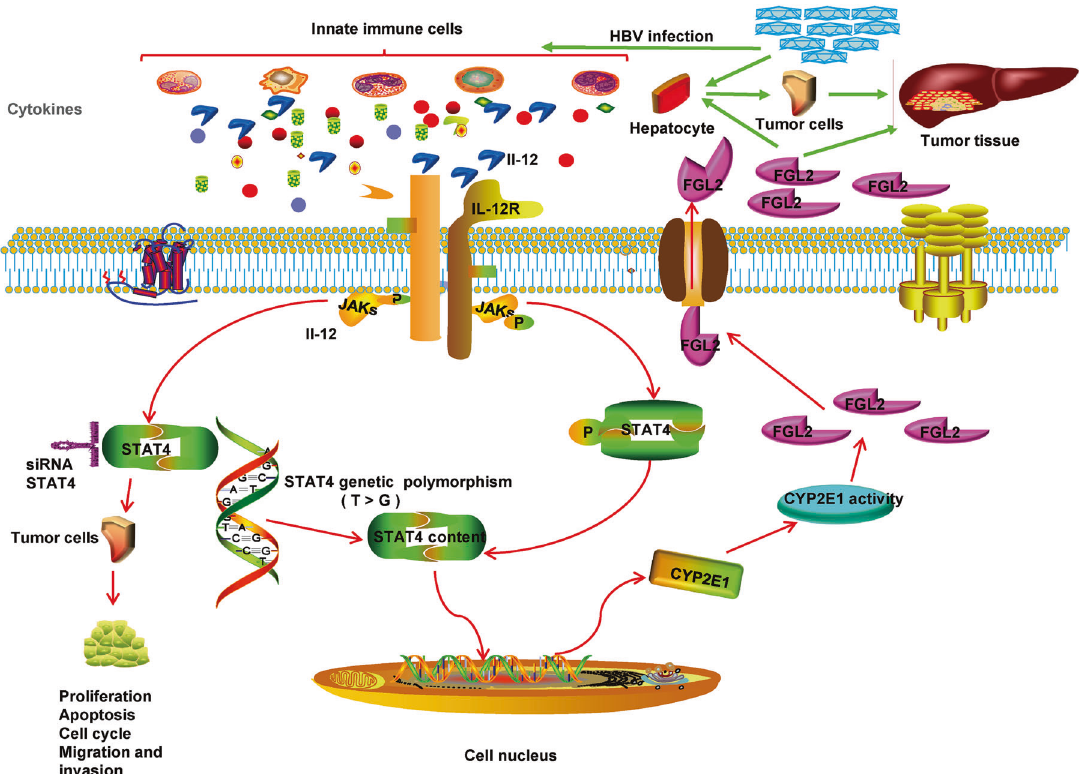
Fig. 7 Graphical representation of the possible mechanism by which the stat4 genetic polymorphism affects HCC. STAT4 has dual roles during HCC (i) STAT4 directly promotes HepG2 cell proliferation, migration, and invasion, and affects apoptosis and cell cycle; (ii) Polymorphism rs7574865 participates the occurrence and progression of HCC by regulating the CYP2E1/FGL2